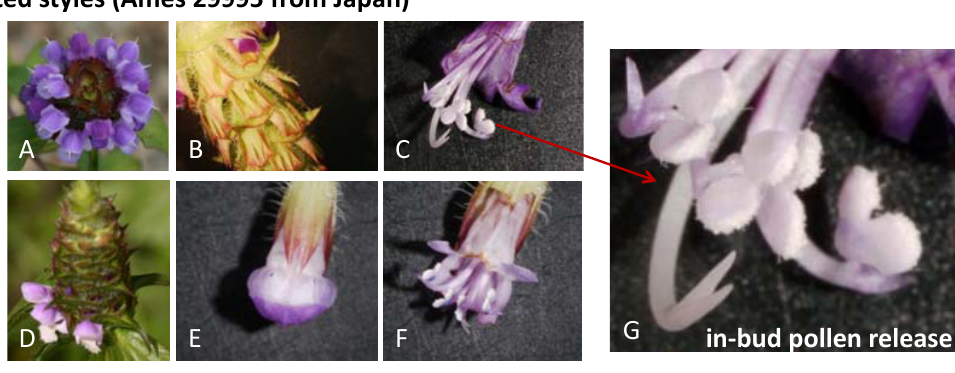
Figure 6. Variation in the breeding system of Prunella vulgaris can be visualized by this comparison of accessions Ames 29995 and PI